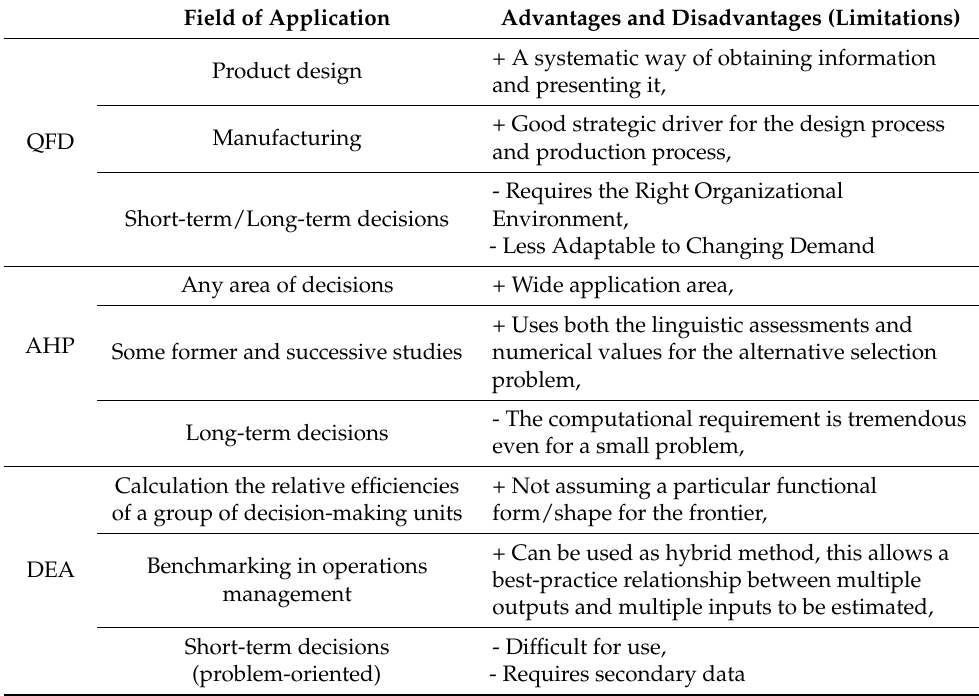
Table 1. Definition and application of product concept’s development